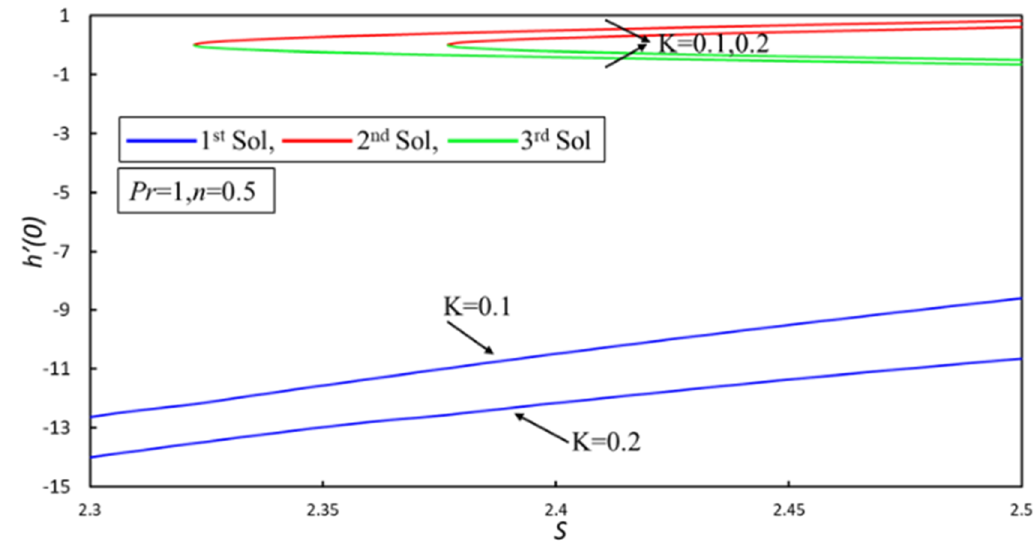
Figure 5. Variation of ℎ′(0) for different fixed values of K with suction parameter S .